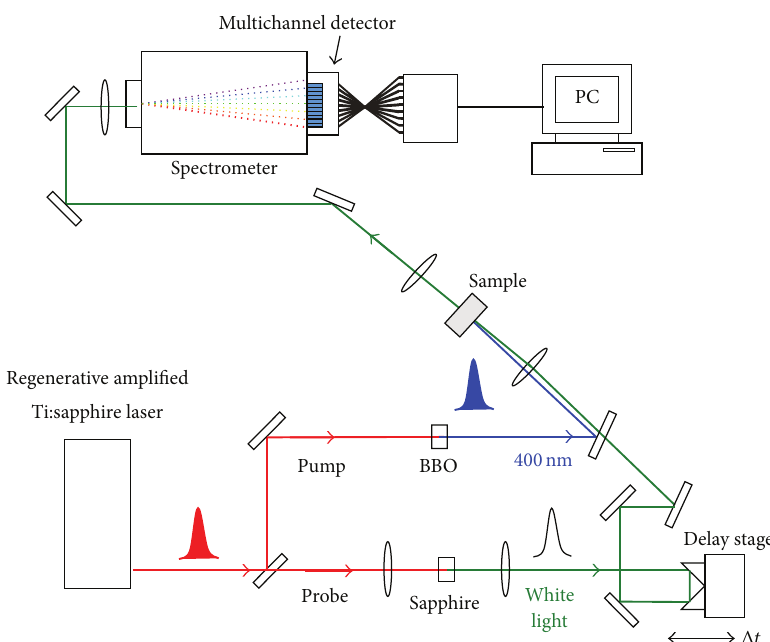
Figure 4: Schematic illustration of the experimental setup for transient absorption